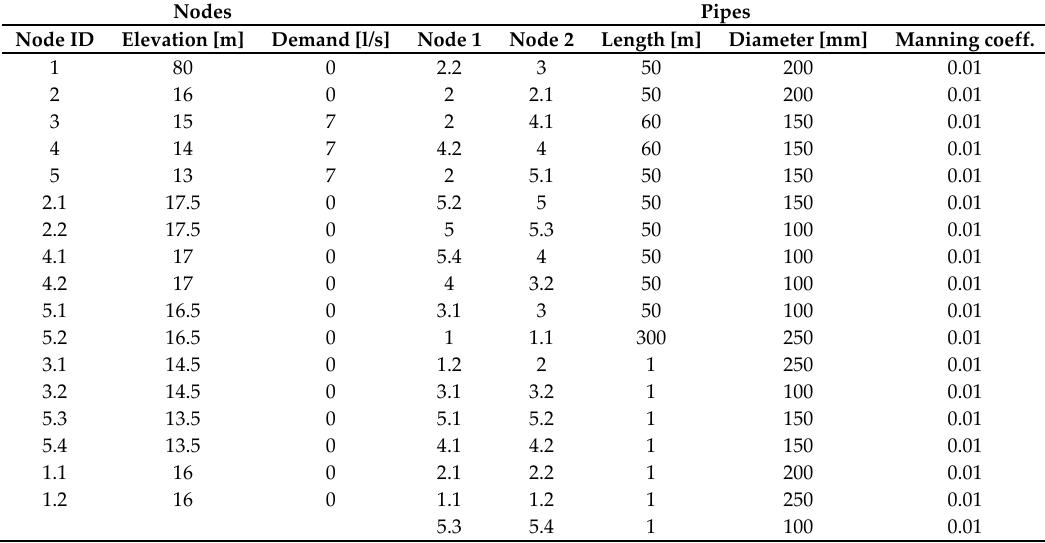
Table 1. Nodes and pipes data of the specified